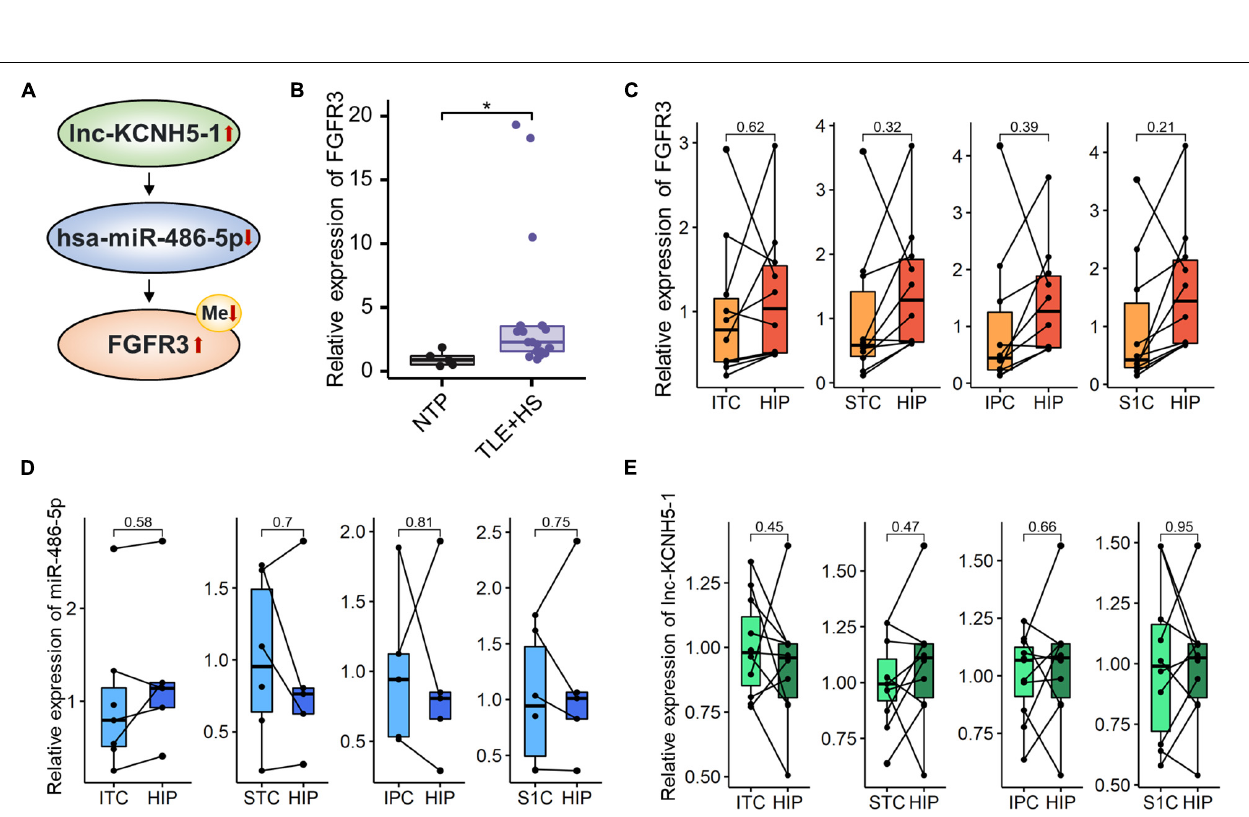
FIGURE 5 | Networks of mRNA/miRNA/lncRNA related to TLE+HS. (A) Integrated regulation relationships of FGFR3, hsa-miR-486-5p, and lnc-KCNH5-1. (B) Validation of the FGFR3 mRNAs expression in another cohort (15 HS and 5 Con). Relative expression of (C) FGFR3, (D) hsa-miR-486-5P, and (E) lnc-KCNH5-1 in hippocampus tissues and different parts of temporal or parietal cortices in BrainSpan database ( n = 10 pairs for FGFR3 and lnc-KCNH5-1, n = 3–5 pairs for hsa-miR-486-5p). NTP, normal temporal or parietal cortices; TLE+HS, temporal lobe epilepsy with hippocampal sclerosis; HIP, hippocampus tissue; ITC, inferolateral temporal cortex tissue; STC, posterior (caudal) superior temporal cortex tissue; IPC, posteroventral (inferior) parietal cortex tissue; S1C, primary somatosensory cortex (parietal cortex) tissue, * p < 0.05.